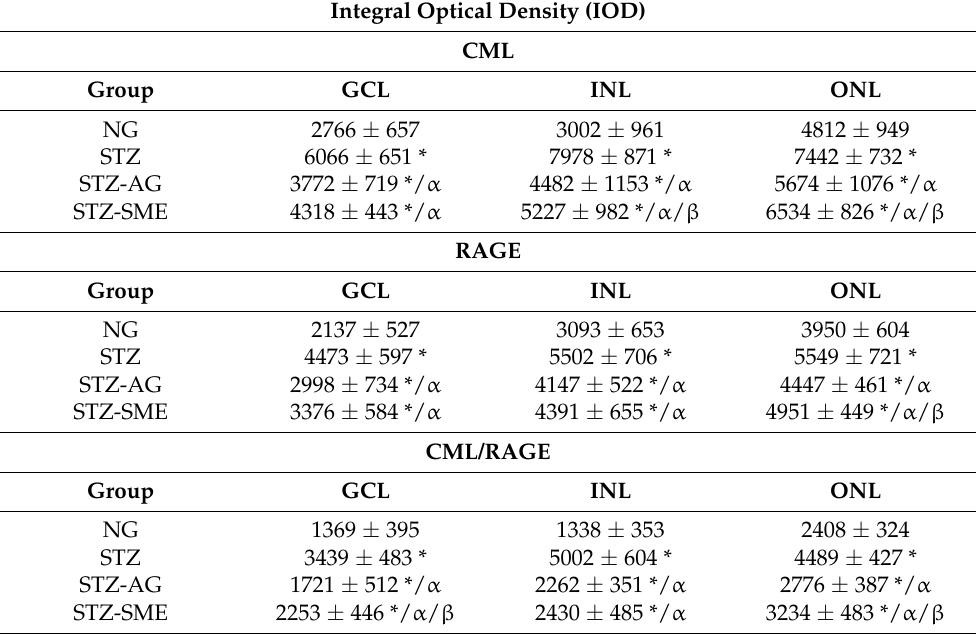
Table A1. Effect of spinach methanolic extract (SME) in the retina of streptozotocin-induced diabetic rats